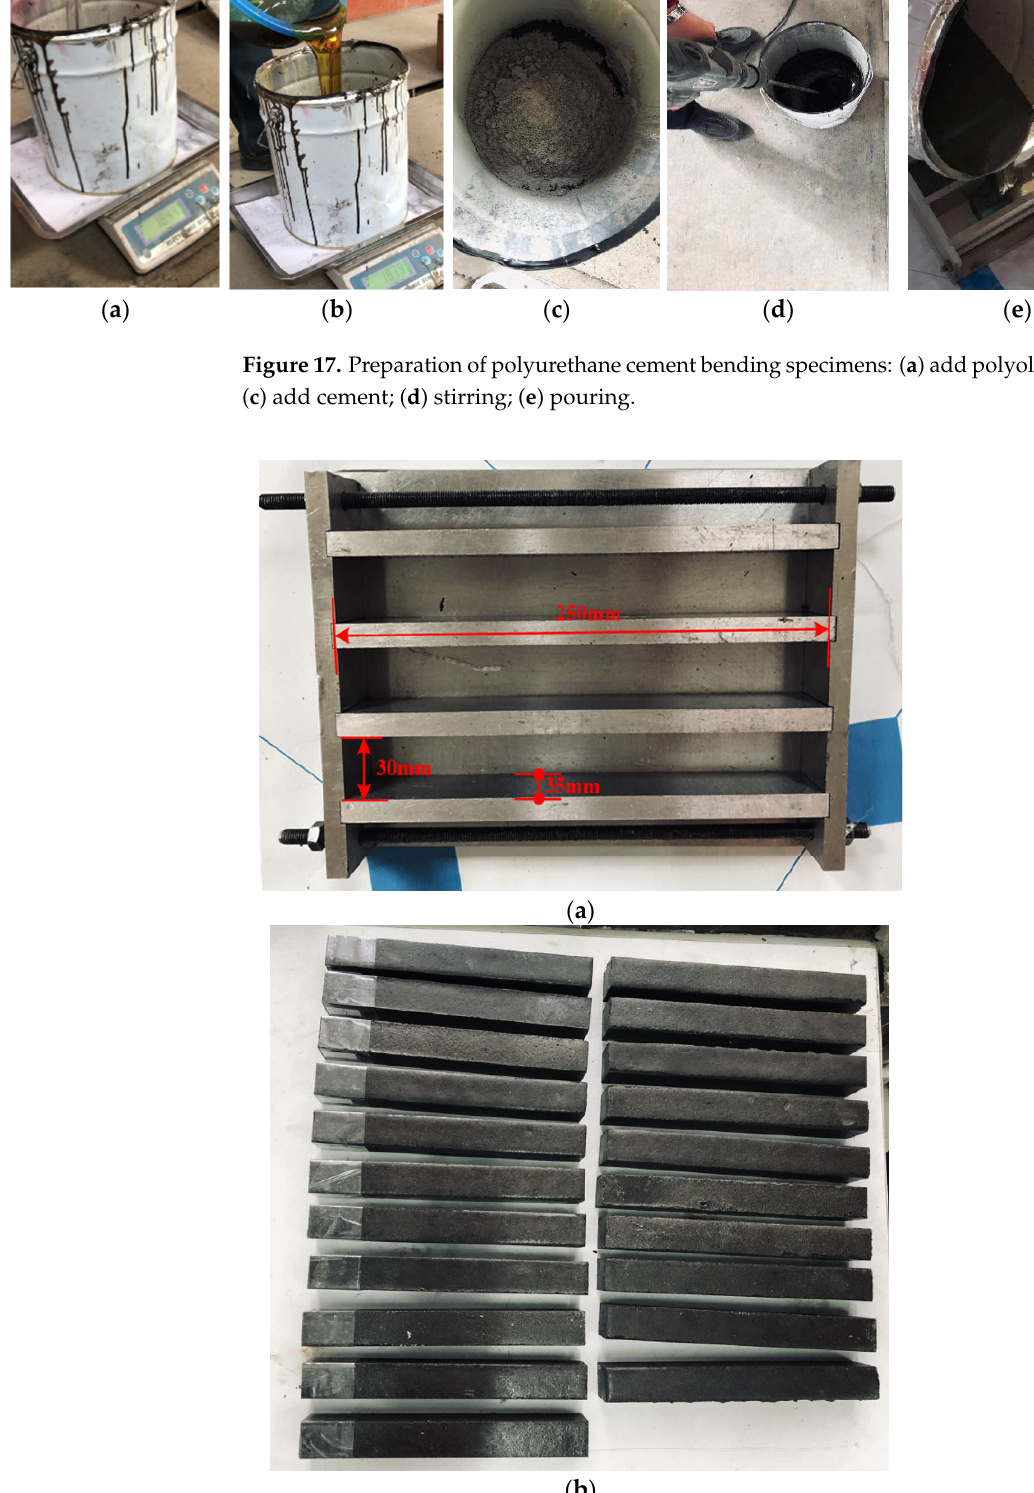
Figure 18. Specimen mold and polyurethane cement specimen: ( a ) polyurethane cement trabecular mold; ( b ) polyurethane cement trabecular specimen.